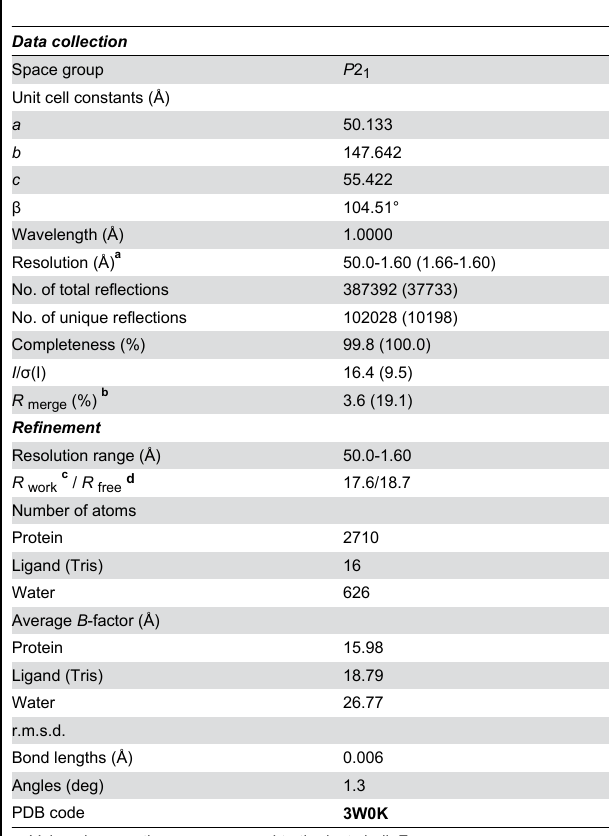
Table 1. Crystallographic data collection and